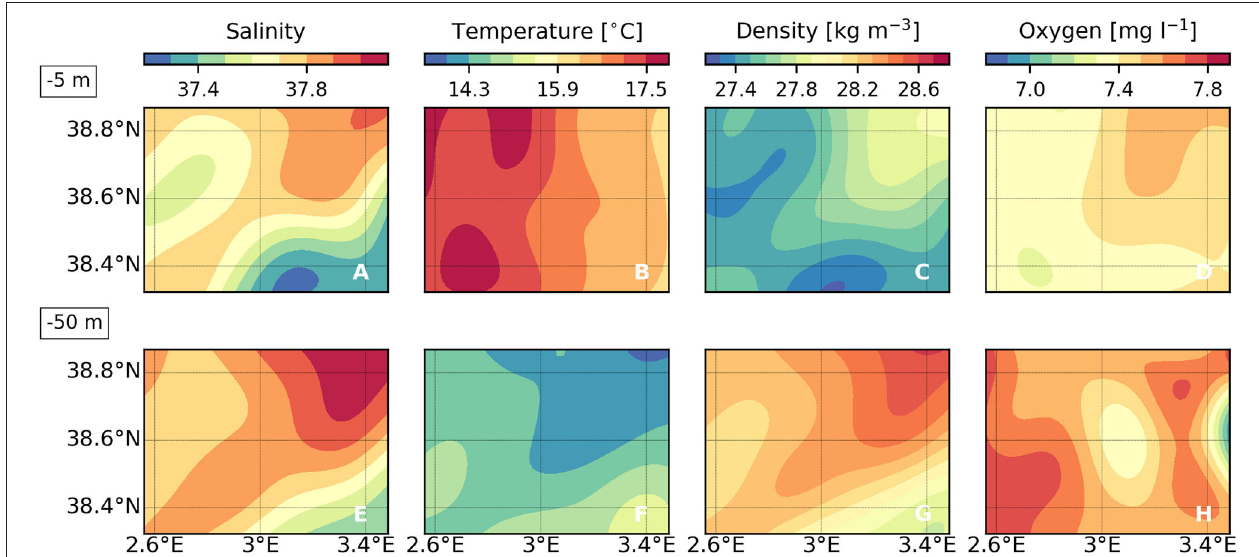
FIGURE 3 | Salinity, temperature, density, and oxygen maps at (A–D) 5 and (E–H) 50 m depth from Leg 1 CTD data.